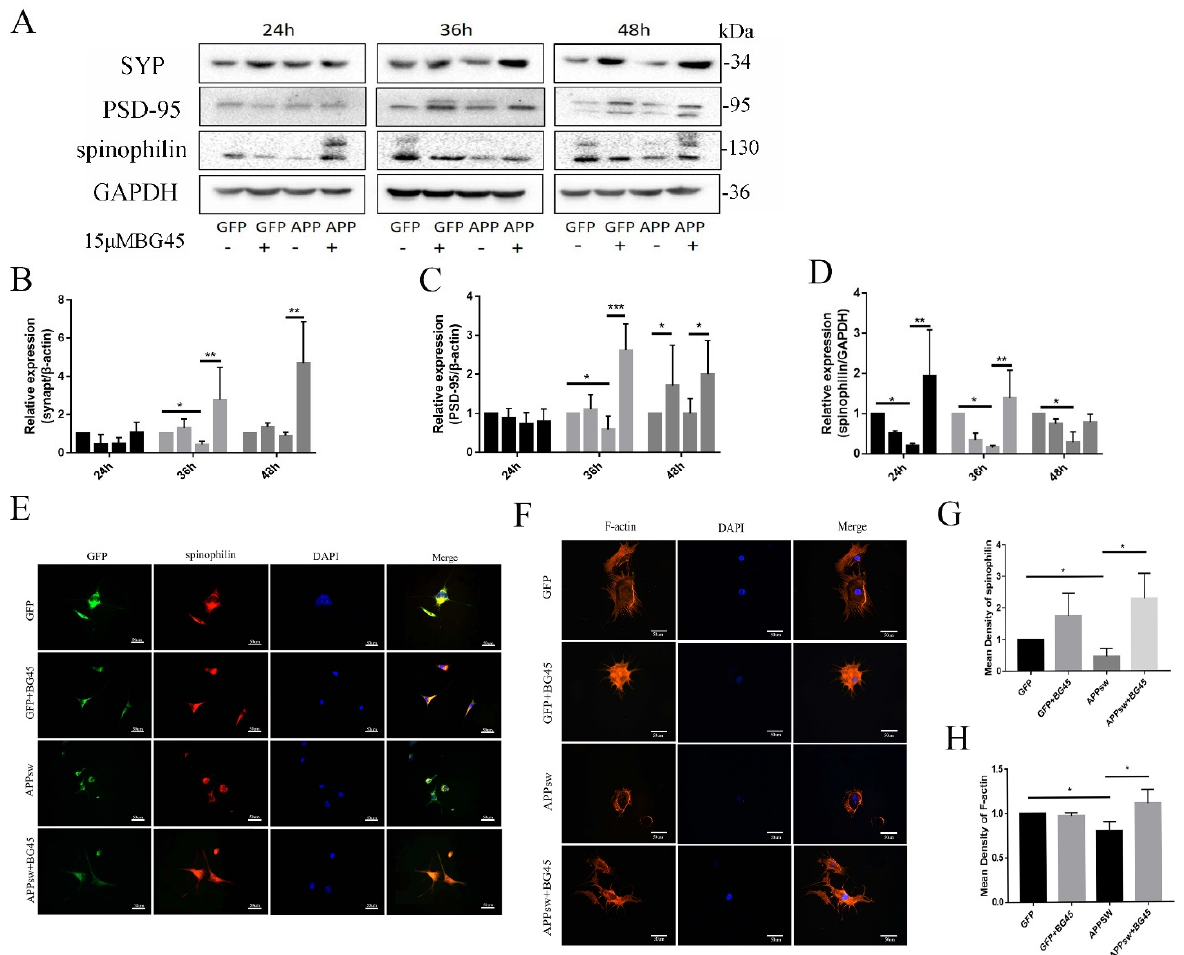
Figure 5. The effects of BG45 on the levels of synapse-related proteins and F-actin. ( A ) Immunoblot analysis of SYP, PSD-95, and spinophilin levels in GFP- and APPsw-positive cells treated with vehicle or BG45 (15 μ M) for different periods (24 h, 36 h, and 48 h). ( B ) Quantification of SYP levels. ( C ) Quantification of PSD-95 levels. ( D ) Quantification of spinophilin levels. ( E ) Immunofluorescence staining for spinophilin in GFP- and APPsw-positive cells treated with vehicle or BG45 (15 µ M) for 36 h. ( F ) Immunofluorescence staining for phalloidin/F-actin in GFP- and APPsw-positive cells treated with vehicle or BG45 (15 µ M) for 36 h. ( G ) Quantification of spinophilin levels. ( H ) Quantification of F-actin levels. Scale bar = 50 µ m ( E , F ). Significant differences were determined using Student’s t -test. All values are presented as the means ± SD from three independent experiments. * p < 0.05, ** p < 0.01, and *** p < 0.001.